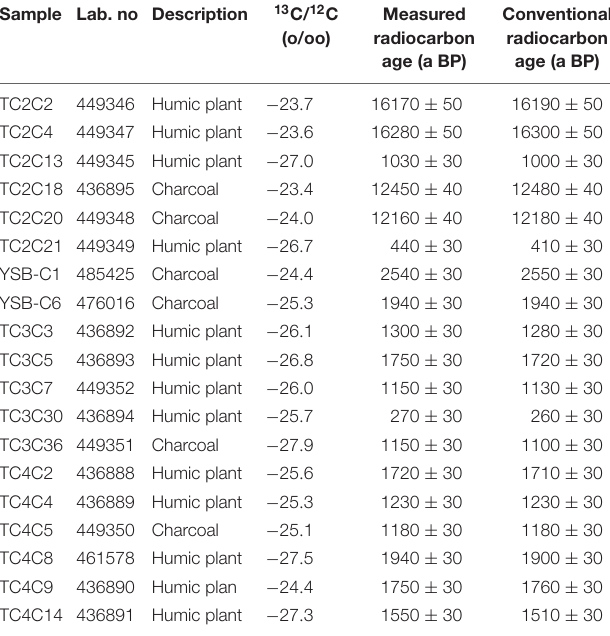
TABLE 1 | Radiocarbon ages from the Yousi trenching site. Sample Lab. no Description 13 C/ 12 C